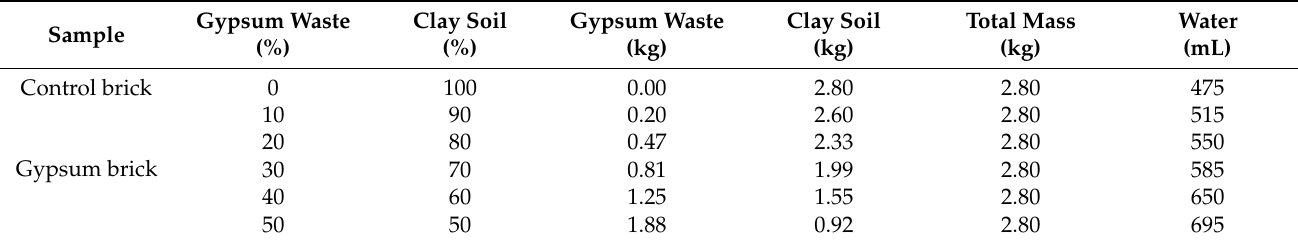
Table 1. Design of mixtures for manufactured fired clay